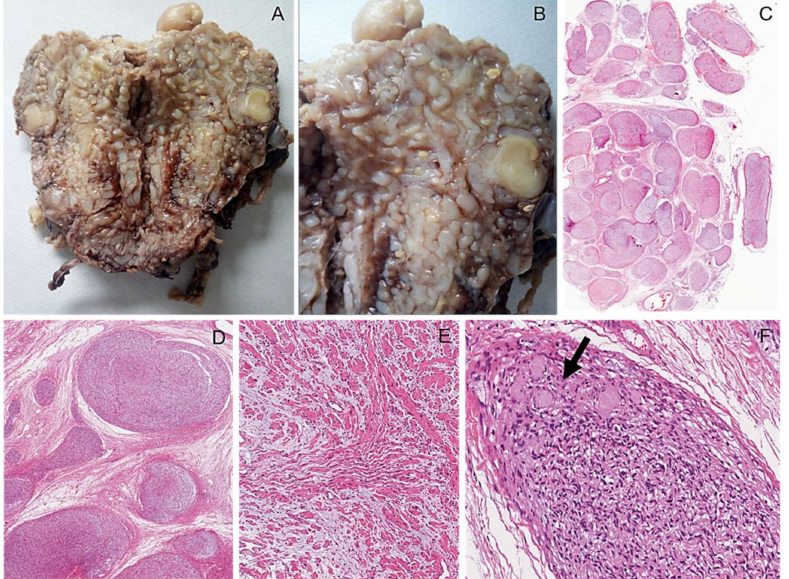
Figure 6. Plexiform neurofibroma. ( A ) Macroscopic appearance of a peritoneal multinodular mass with a plexiform pattern and greyish color; ( B ) the classic “ bag of worms appearance ” can be noticed. ( C ) Low-magnification images showing the typical nodular/plexiform growth pattern. ( D ) High- magnification image showing serpentine nerve-like structures embedded in an abundant myxo- edematous stroma rich in haphazardly arranged thick collagen fibers ( shredded carrots appearance ) ( E ). Occasional Wagner–Meissner corpuscles (lamellar growth pattern) can be observed (arrow) ( F